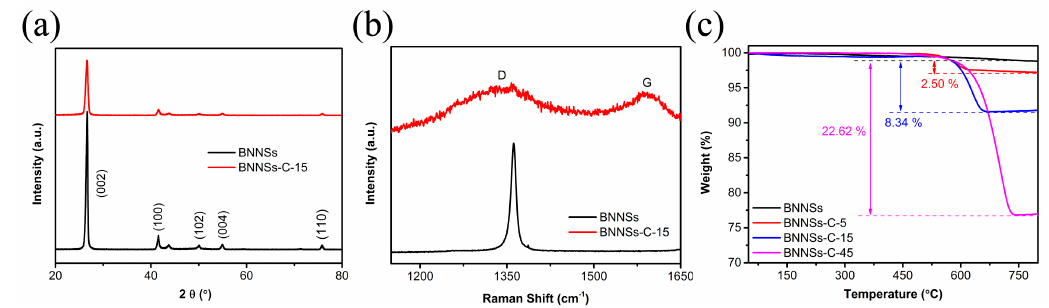
Figure 3. ( a ) XRD patterns; ( b ) Raman spectra; and ( c ) TGA curves of pristine BNNSs and corresponding BNNSs@C hybrids with different CVD deposition times.